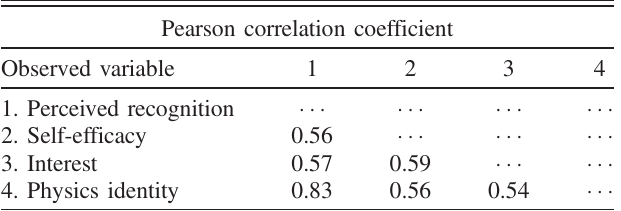
TABLE II. Pearson intercorrelations are given between all the predictors and outcomes for the postsurvey in physics 2. All p values < 0 . 001 .